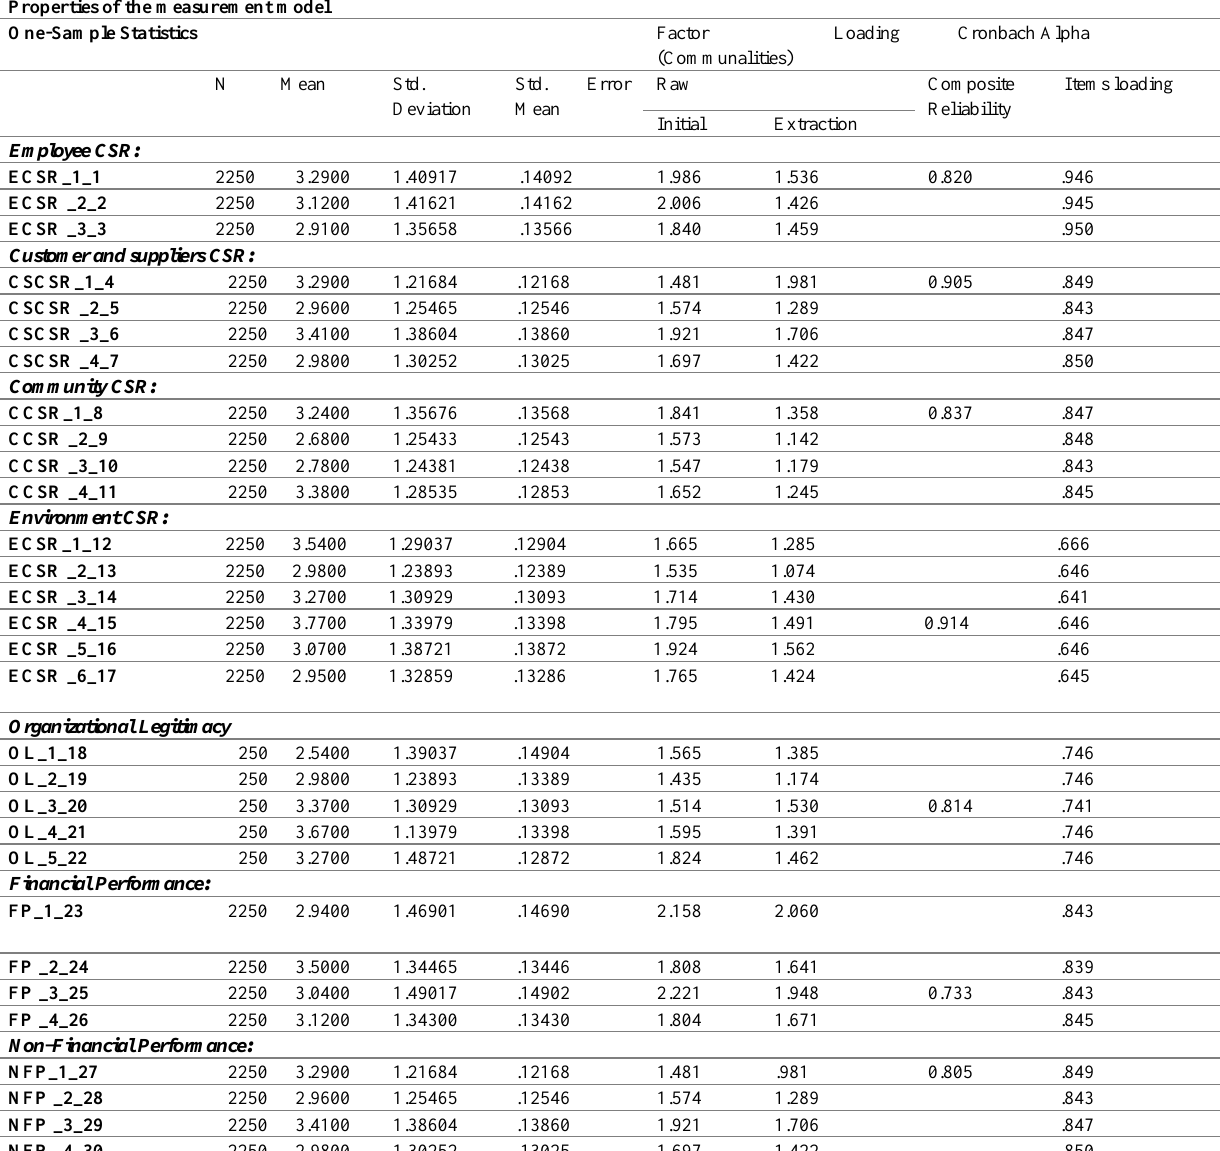
Table 4: Reliability and